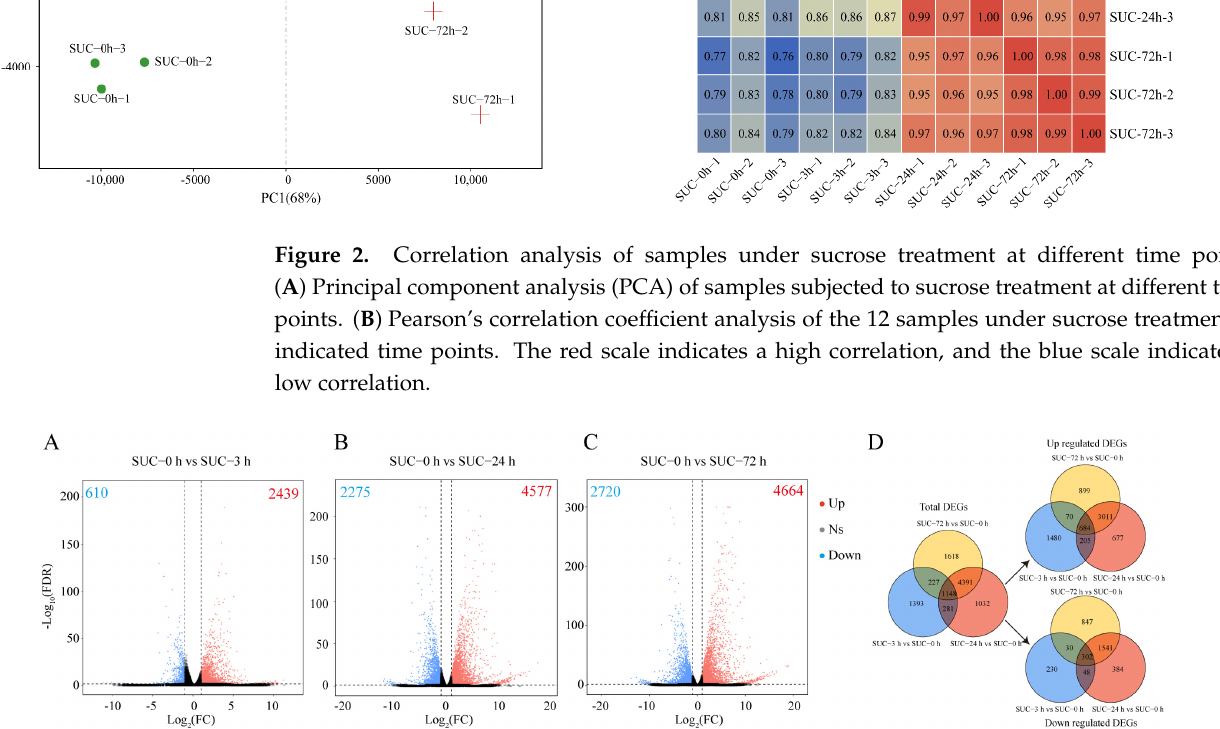
Figure 3 . Analysis of DEGs in different groups. ( A ) Volcano plot of DEGs in response to sucrose treatment for 0 h vs. 3 h. ( B ) Volcano plot of DEGs in response to sucrose treatment for 0 h vs. 24 h. ( C ) Volcano plot of DEGs in response to sucrose treatment for 0 h vs. 72 h. ( D ) Venn diagram of the DEGs in different groups under sucrose treatment. Red dots indicate upregulated genes, and blue dots indicate downregulated genes. Gray dots indicate no significant differentially expressed genes. Ns, no significant difference. The numbers of upregulated and downregulated DEGs are shown in the corresponding figures.